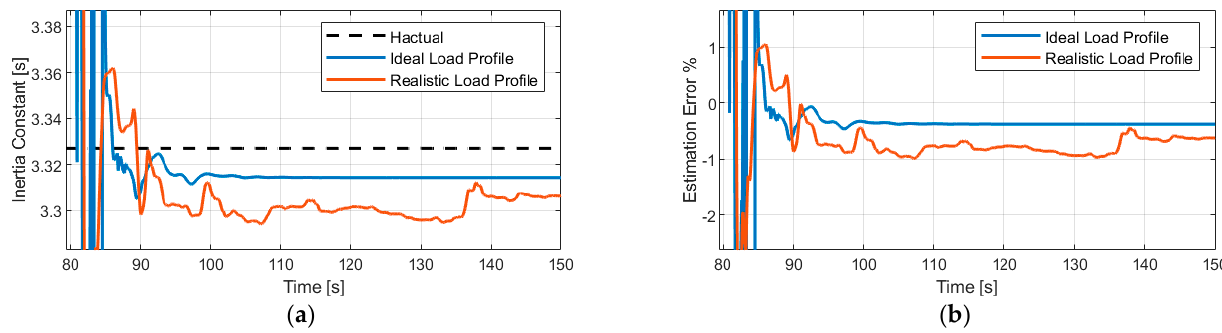
Figure 3. The inertia estimation performance under different load profiles in terms of ( a ) the estimated total inertia constant and ( b ) the relative estimation error of the actual total inertia constant.